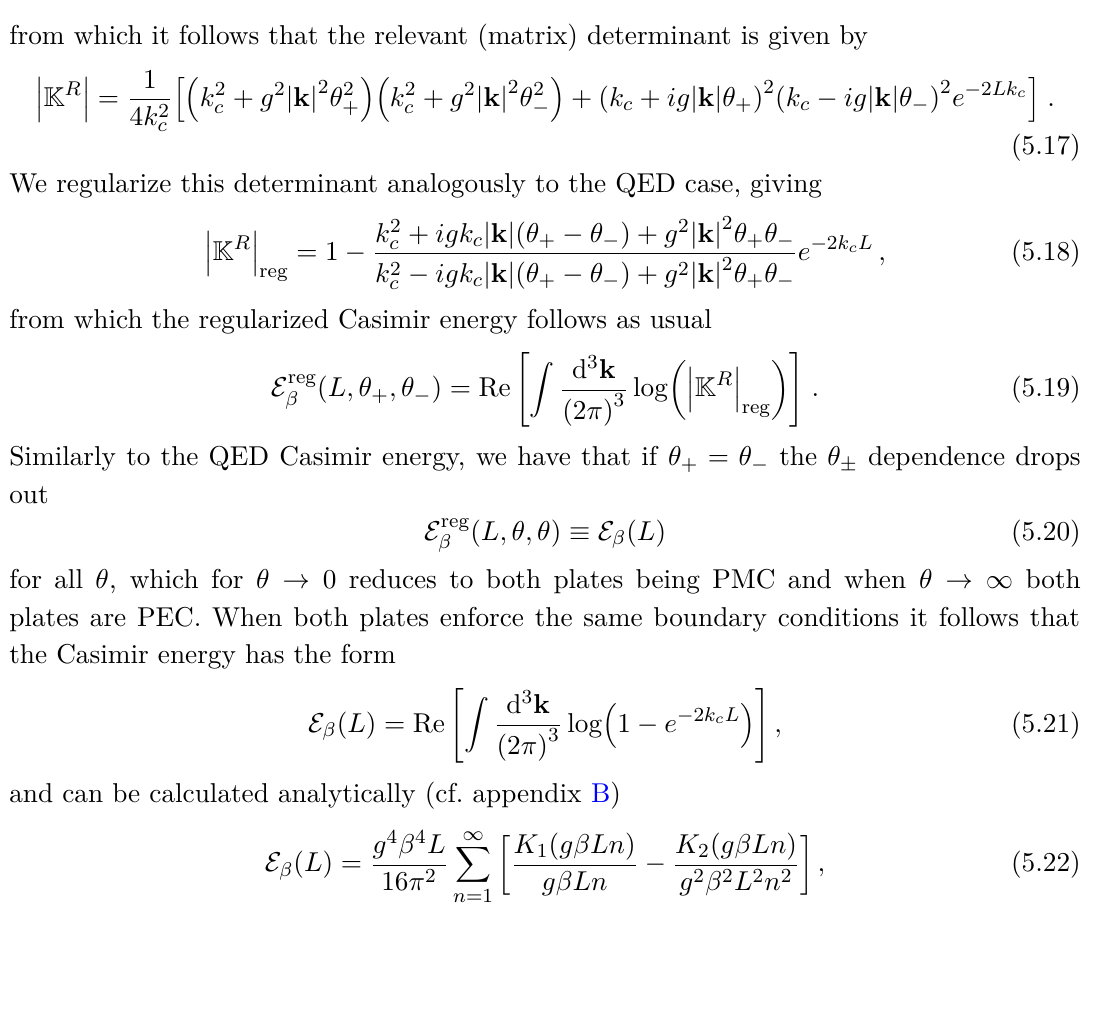
= arctan( gθ ± ) . ± − θ 0 ≈ 0 . 755 , where it + −